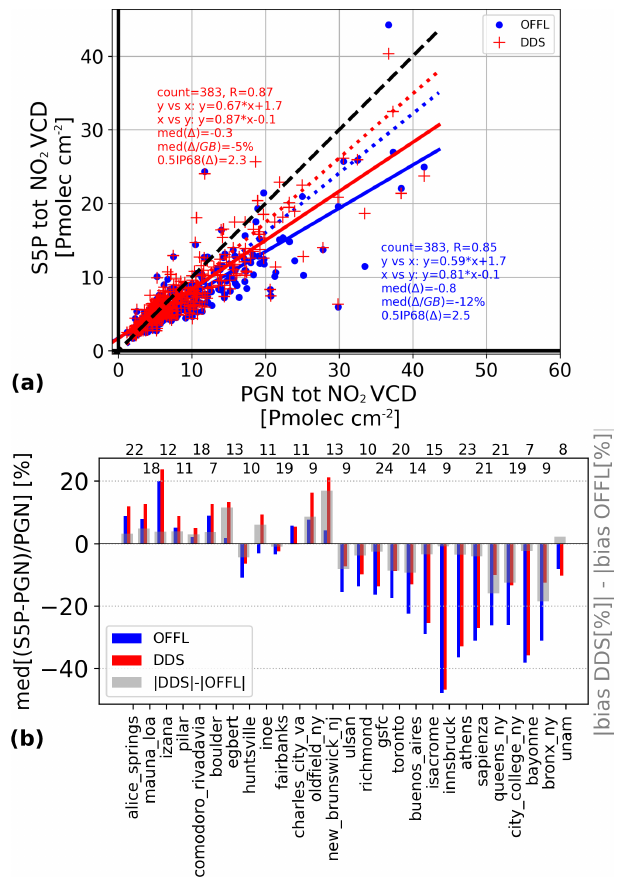
Figure 17. Similar to Fig. 15 but for S5P/TROPOMI vs. PGN total NO 2 column measurements, which require no photochemical ad- justment. Sites in panel (b) are ordered along increasing PGN total